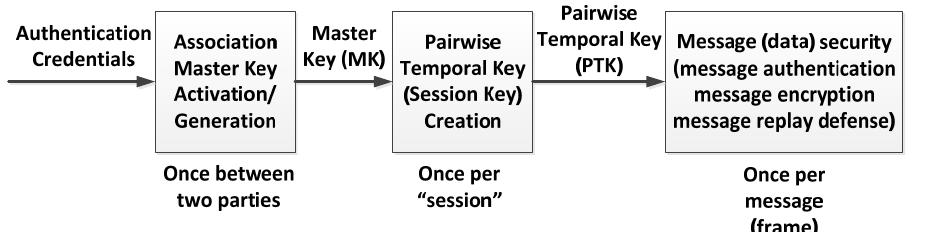
Figure 16. Security Hierarchy